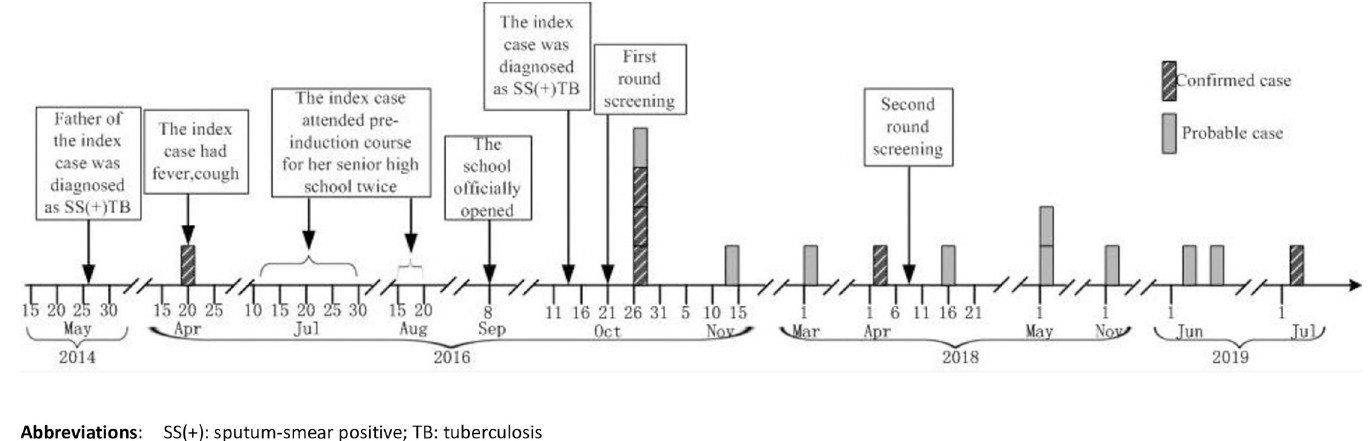
Fig 1. Timeline of probable and confirmed TB cases in a high school: Zhejiang Province, China, 2016 to 2019.